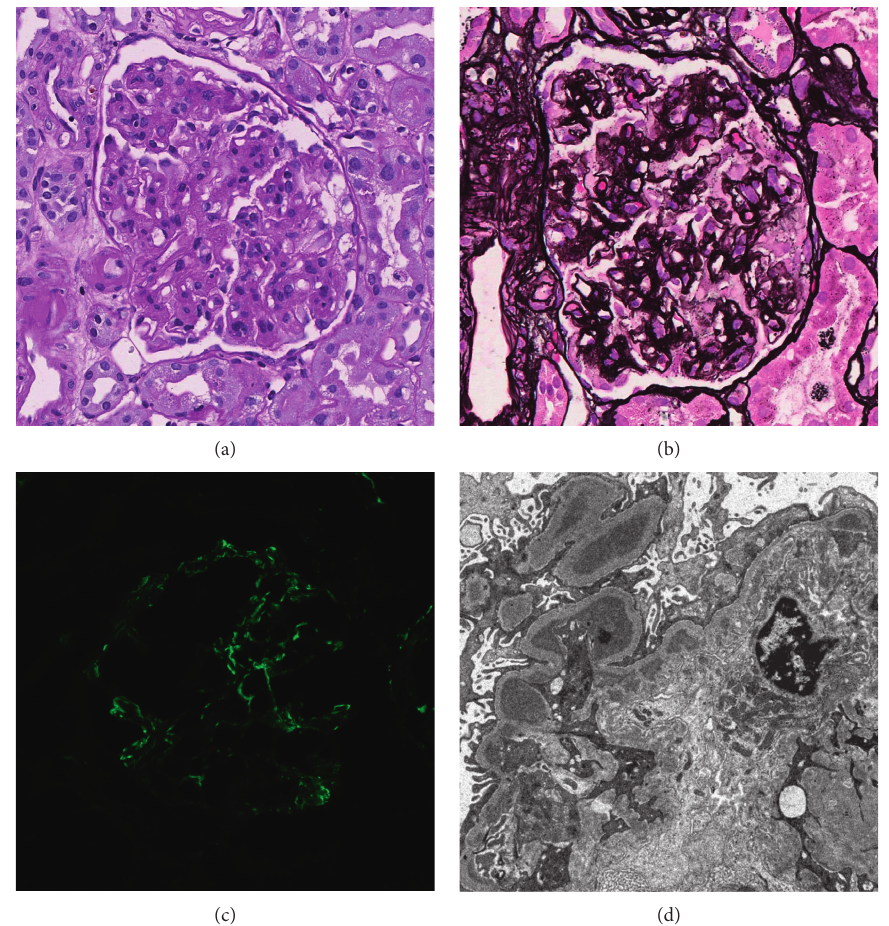
Figure 1: Kidney biopsy findings. (a) Periodic acid-Schiff and (b) Jones methenamine silver-stained sections demonstrate mild-to-moderate mesangial widening and minimal endocapillary proliferation with associated segmental double contours of the glomerular basement membrane. (c) C3-dominant staining is present in the mesangium and peripheral glomerular capillary loops. (d) Electron microscopy reveals subendothelial immune deposits with evidence of glomerular basement membrane